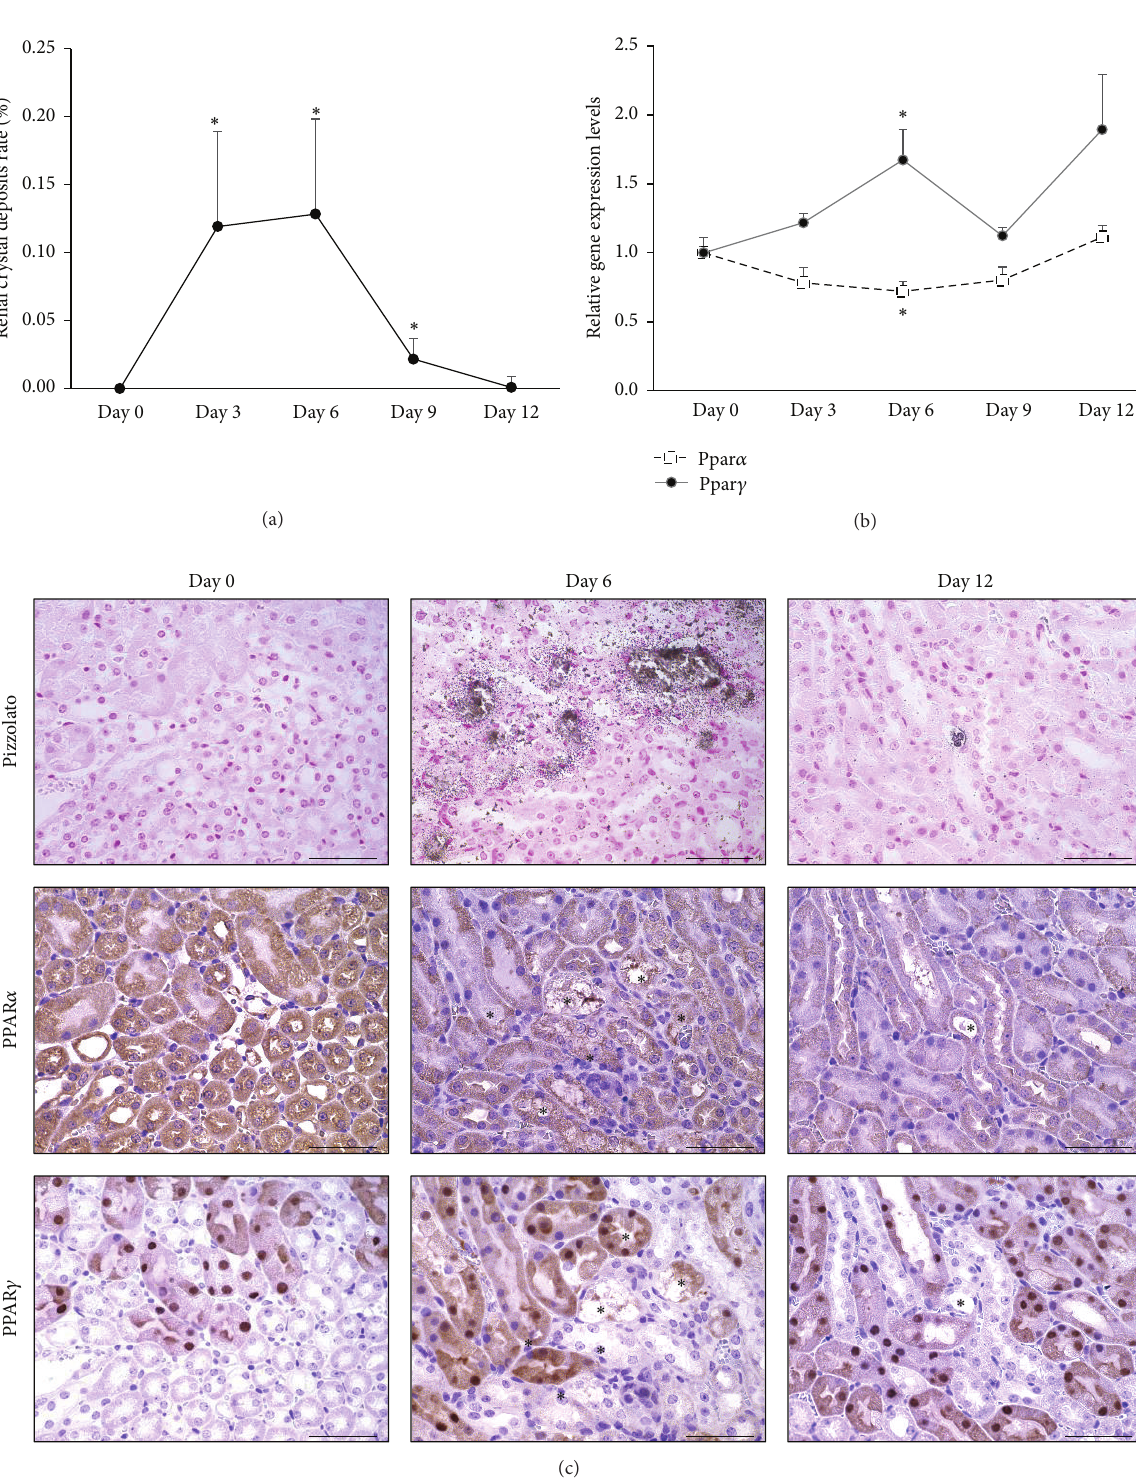
Figure 1: Renal CaOx crystal formation and PPAR expression in hyperoxaluric mice. (a) Quantitative estimation of renal CaOx crystals. Crystallization in each kidney section on designed time points was quantified by calculating the ratio (%) of the area containing crystals to that of the entire kidney section by using Image Pro Plus. (b) Evaluation of PPAR 𝛼 and PPAR 𝛾 expression by qRT-PCR using TaqMan assays ( 𝑛 = 6 for each time point). Control values represent the average on day 0 and data are presented as mean ± SE. ∗ 𝑝 < 0.05 versus gene expression on day 0. (c) PPAR 𝛼 and PPAR 𝛾 immunohistochemistry in hyperoxaluric mouse kidneys obtained on days 0, 6, and 12. Each asterisk represents the location of CaOx crystals detected by Pizzolato staining. Magnification: 400x. Scale bar = 50 𝜇